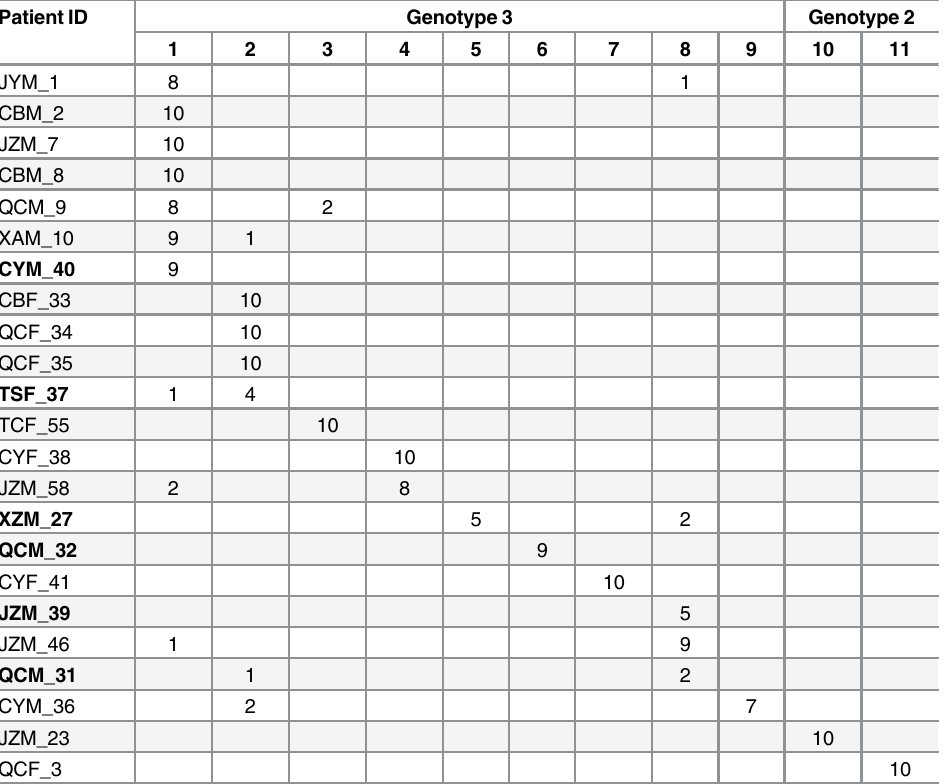
Table 3. The number of sequences shared by the patients for a given clade after the exclusion of recombinant sequences.